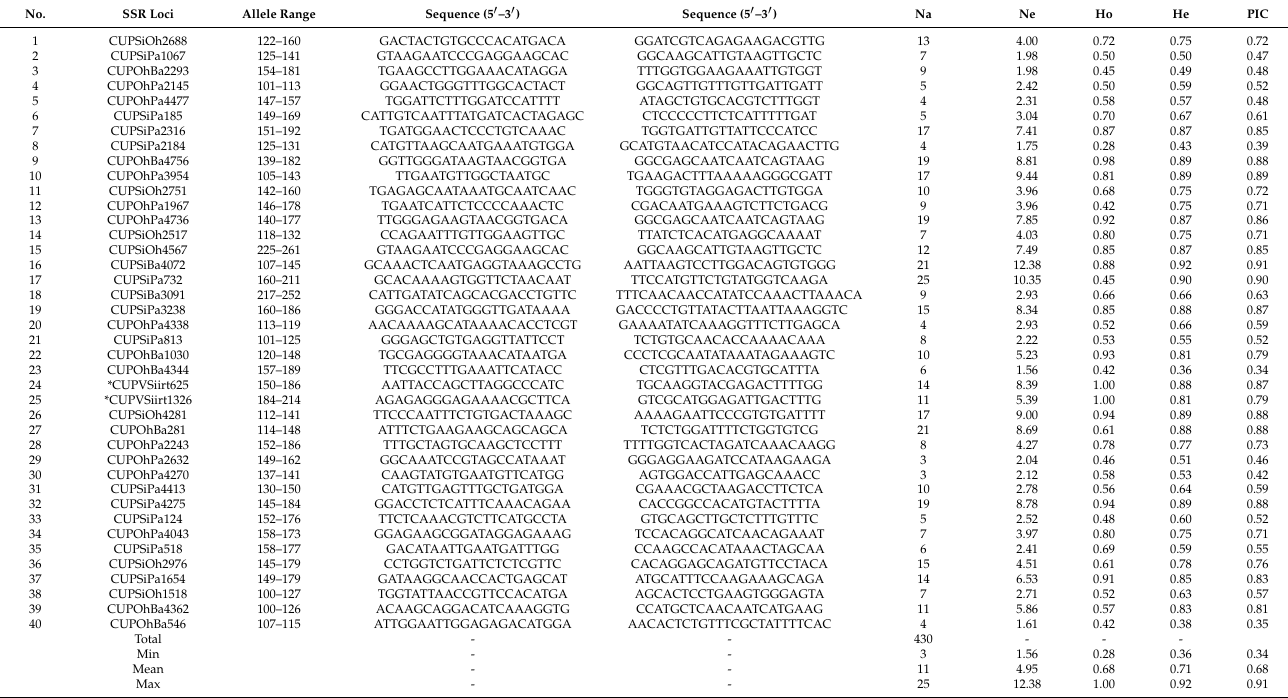
Table 3. Sequence, allele range, number of alleles (Na), number of effective alleles (Ne), observed heterozygosity (Ho), expected heterozygosity (He), and polymorphism information content (PIC) values based on 40 in silico polymorphic SSR and SSR